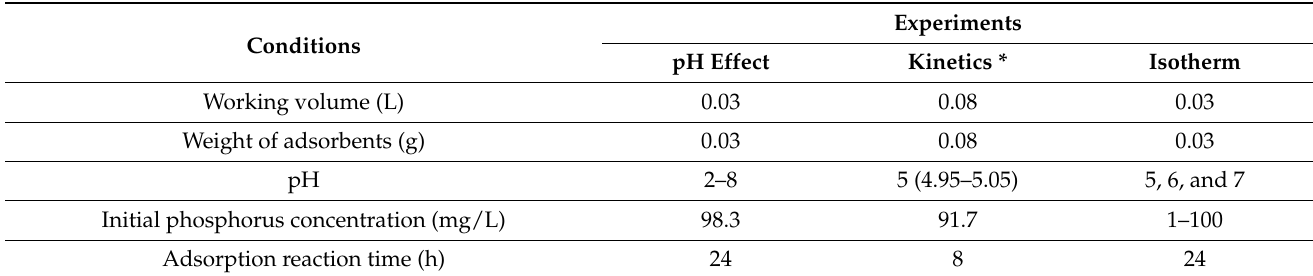
Table 1. Adsorption experimental